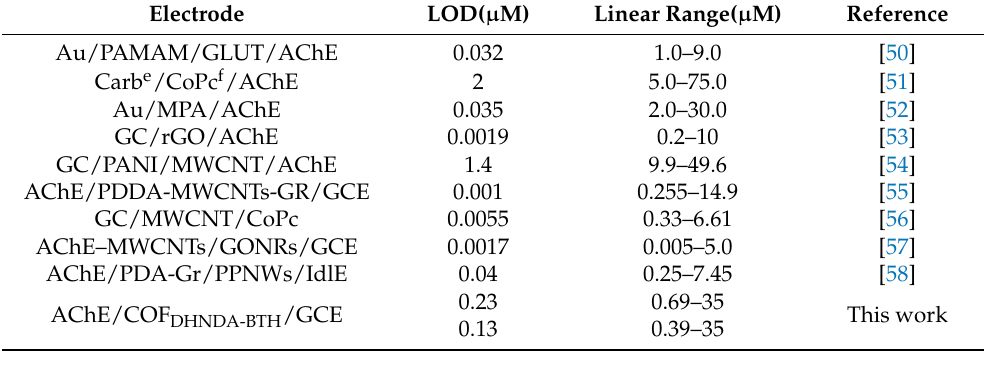
Table 1. The comparison of AChE/COF DHNDA-BTH /GCE biosensor with other biosensors.